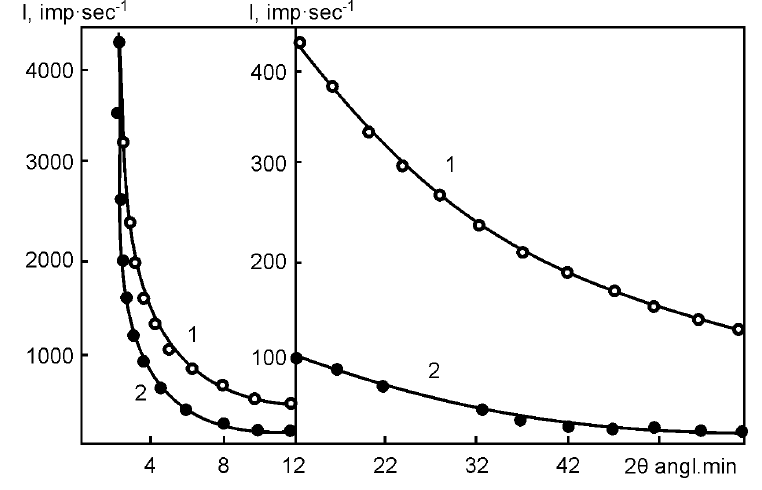
Figure 1. Small-angle X-ray scattering (SAXS) indicatrix for Cu coatings precipitated under Earth-based ( 1 ) and space ( 2 )